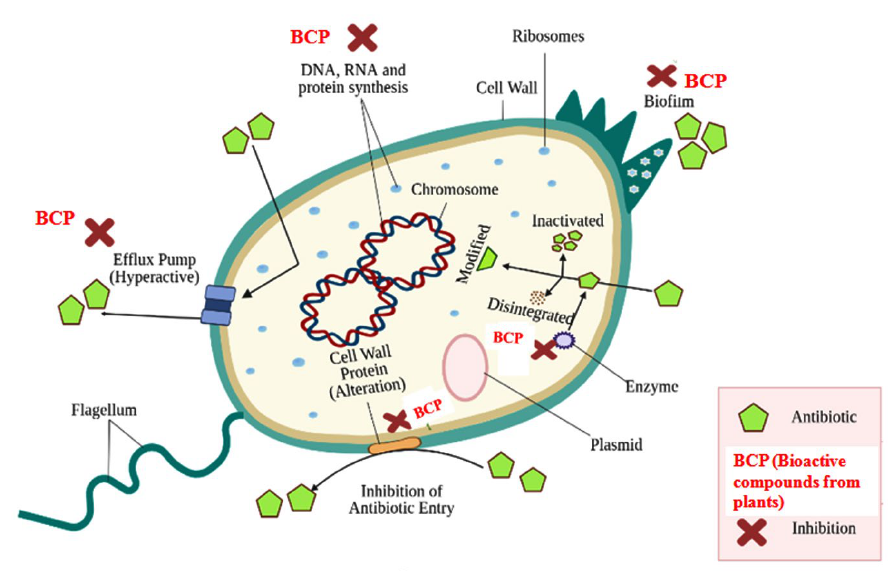
Fig. 4. Antibiotic resistance mechanisms and mode of action of plant bioactive compounds against bacterial strains. Reproduced from 48 under the Creative Commons Attribution (CC BY) license (http://creativecommons.org/licenses/